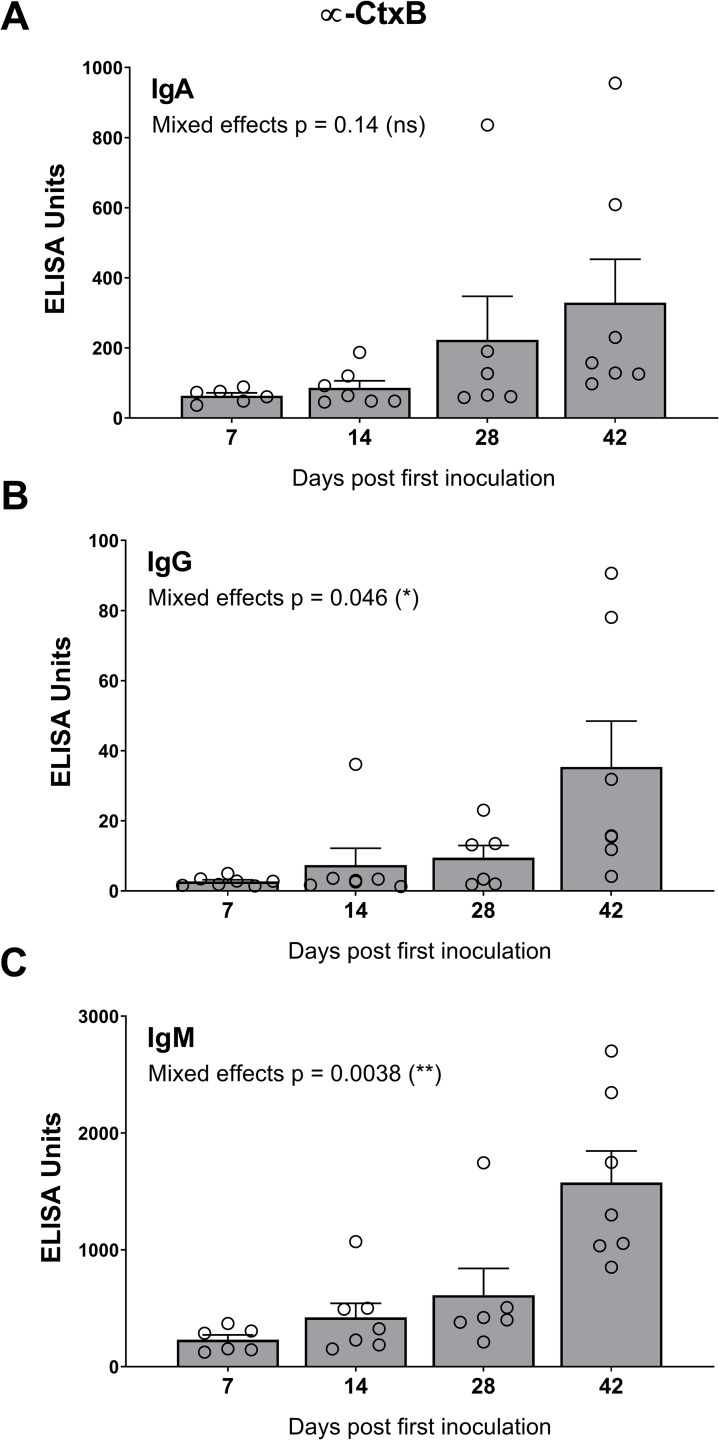
Isotype specific anti-CtxB titers in C57BL/6 mice immunized with HaitiV.Anti-CtxB titers with specific isotype analysis for IgA (A), IgG (B) and IgM (C) were performed for each serum sample. The mean ± SEM is indicated. Mixed-effect p-values were determined by one-way ANOVA analysis. Multiple comparison p-values for this data are reported in S1 Table. Although there were 7 mice per group, some samples were of insufficient volume for analysis.